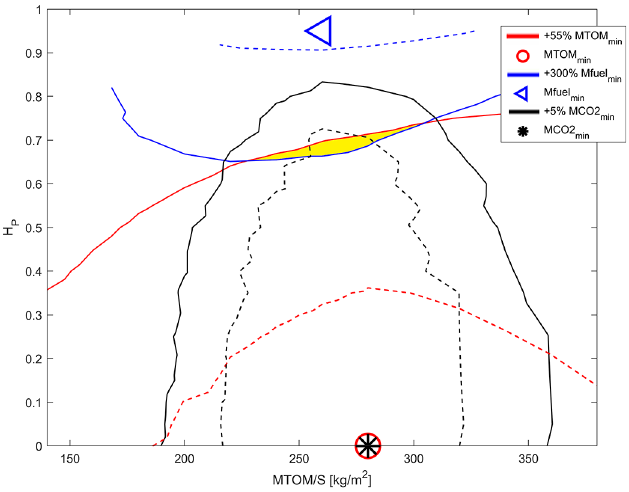
Fig. 13. The region (yellow) of the possible aircraft con fi gura- tions for BED= 1000 Wh/kg.